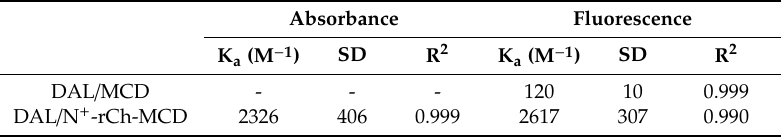
Table 1. Association constant (K a ) determined by UV absorbance or fluorescence spectrometry, for DAL complexing with 2-methyl-β-cyclodextrin (MCD) or N + -rCh-MCD. Standard deviation (SD) and the coefficient of determination (R 2 ) of the linear regression are also displayed.